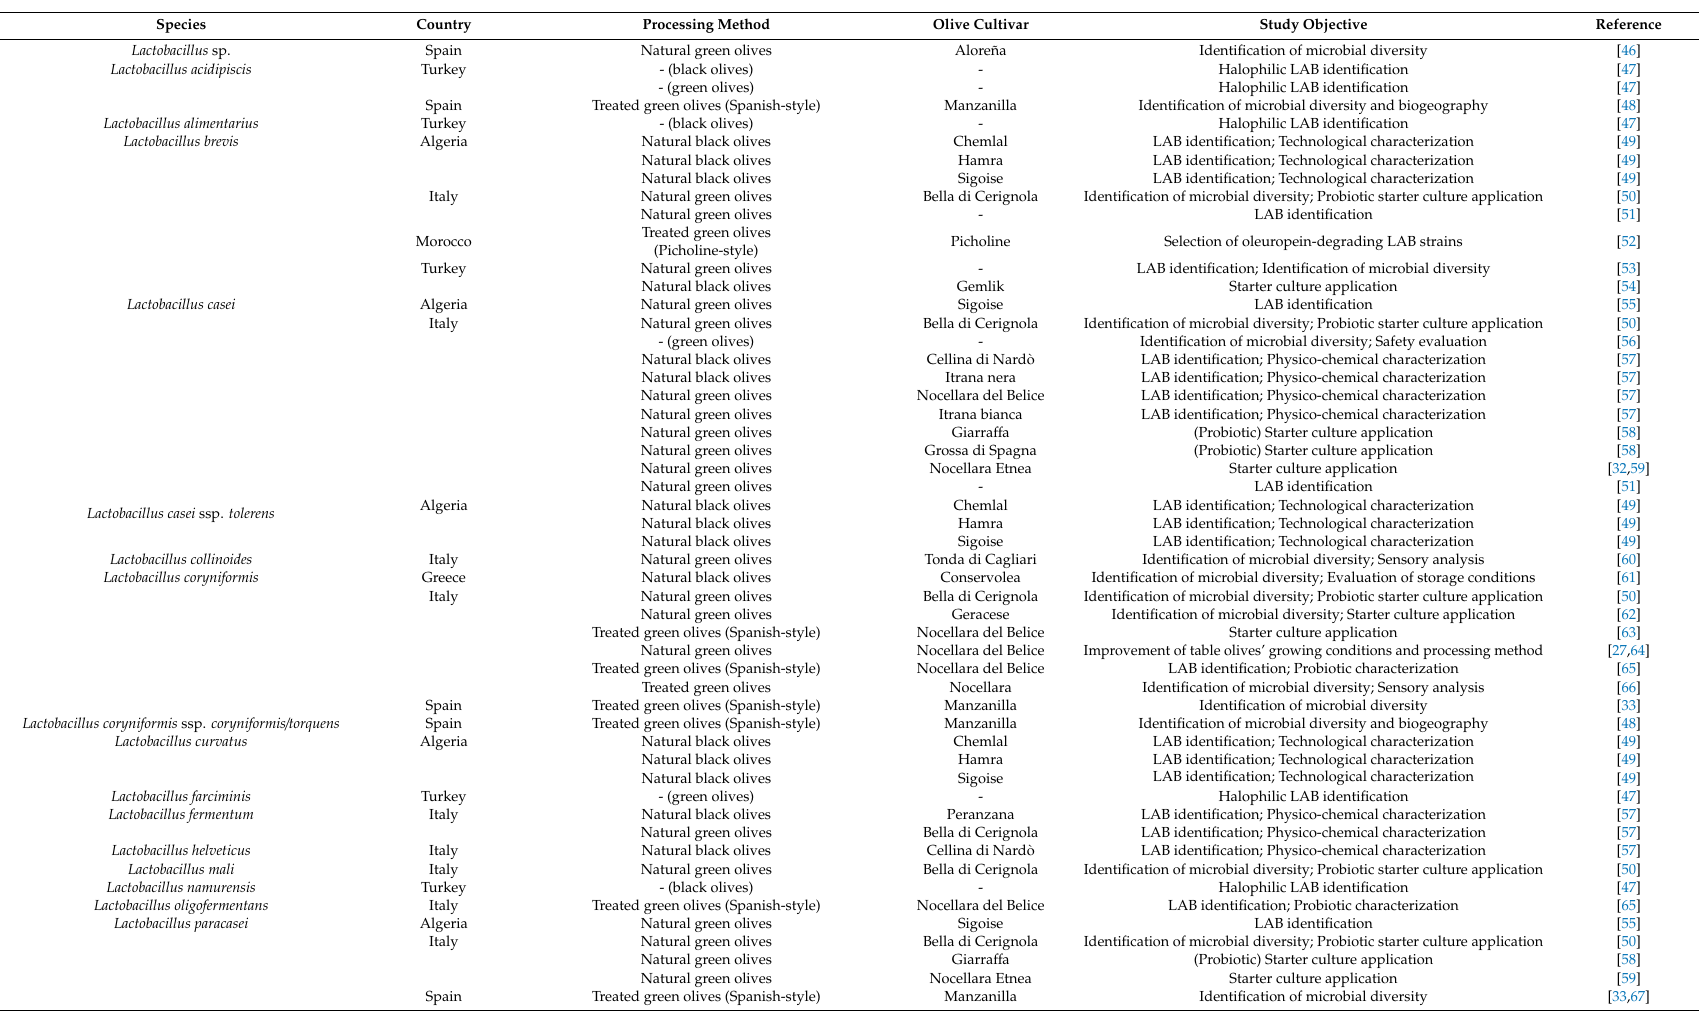
Table 2. Lactobacillus species isolated from di ff erent processing methods of table